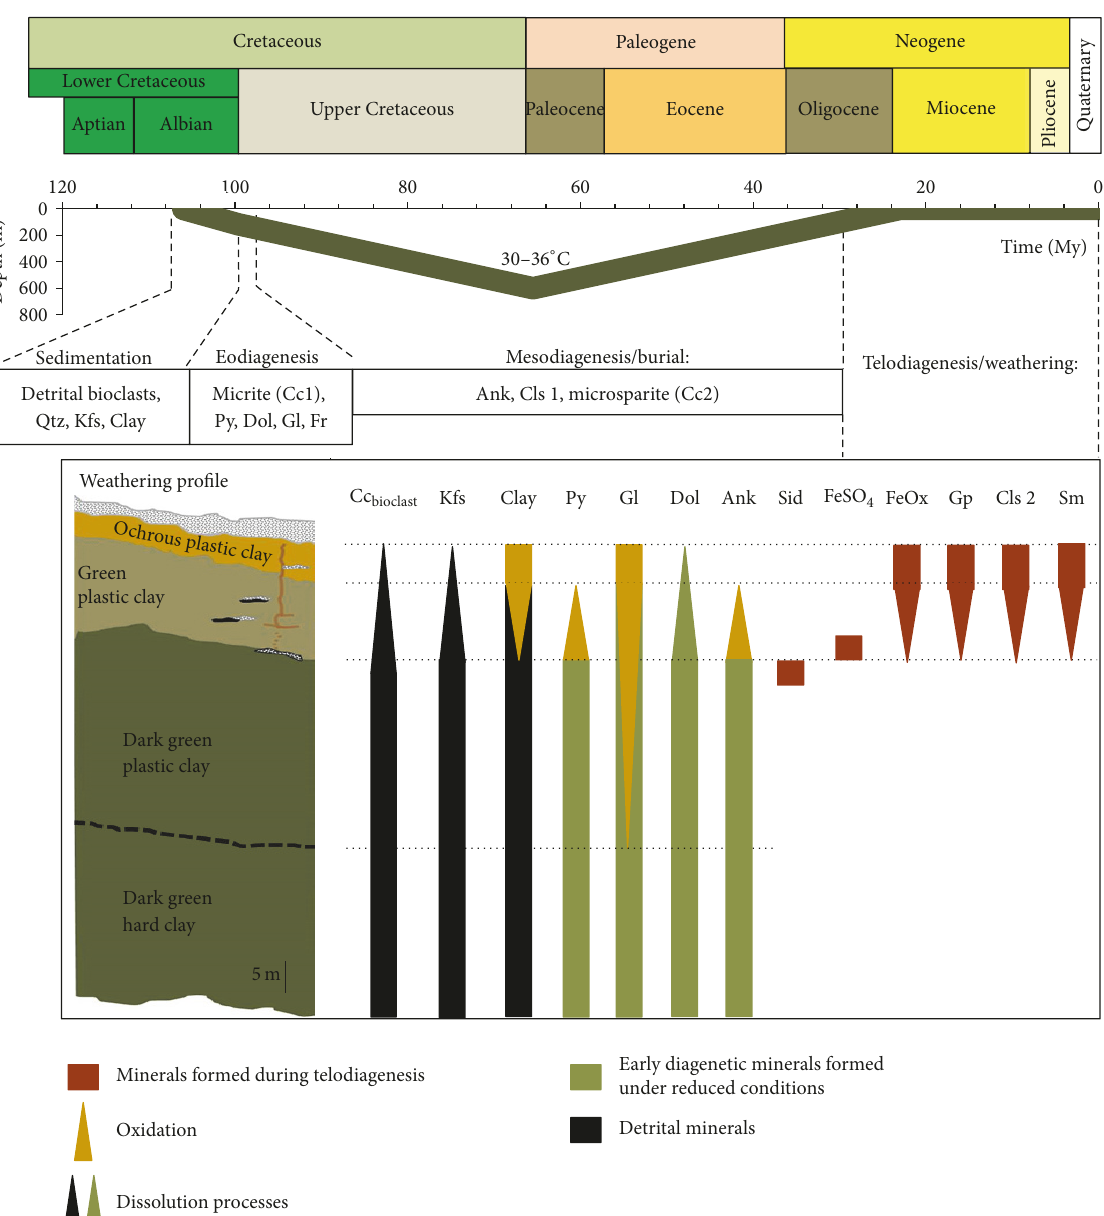
Figure 10: Burial curve proposed for the T´egulines Clay and diagenetic mineral sequence. The mineral sequence including processes of dissolution, oxidation, and precipitation is detailed in function of depth for the telodiagenesis. Ank, ankerite; Cc bioclast, calcite from detrital bioclasts; Clay, undifferentiated detrital clay matrix including kaolinite, illite-smectite mixed layer minerals, chlorite, illite/mica; Cls, celestite; Dol, dolomite; FeOx, iron oxide-hydroxides; fr, francolite; Gl, glauconite; Gp, gypsum; Kfs, potassic feldspar; Py, pyrite; Qtz, quartz; Sid, siderite; Sm,